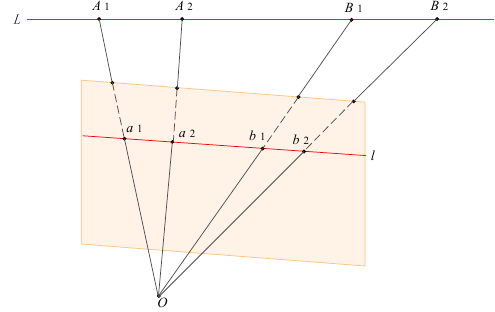
Figure 5. Spatial line reprojection model.